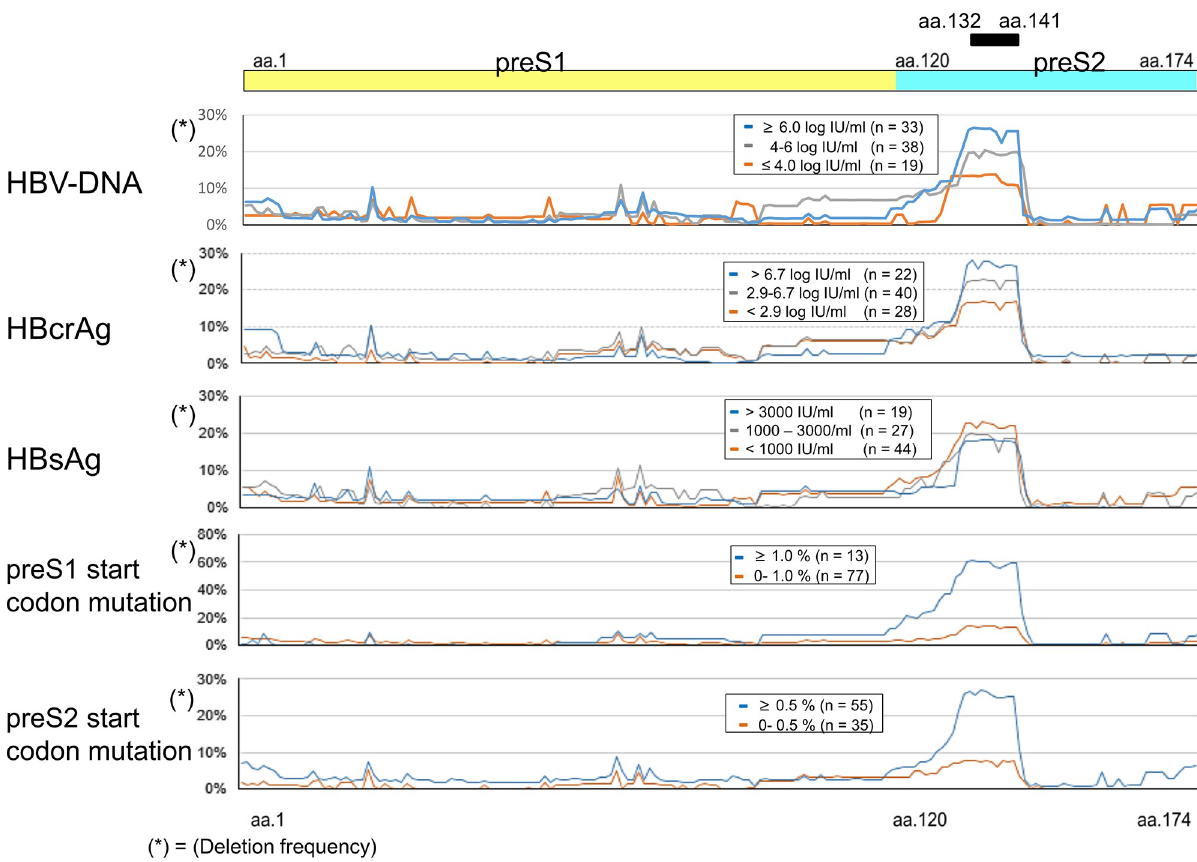
Fig 3. PreS deletion frequency and its association with viral markers. The preS deletion frequency and its association with viral markers (HBV DNA, HBcrAg, HBsAg, preS1 start codon mutation, and preS2 start codon mutation). A, The patients were stratified into three groups according to their HBV DNA titers( � 6.0 log IU/ml, n = 33, 4.0–6.0 log IU/ml, n = 38 and � 4.0 log IU/ml, n = 19). B. The patients were stratified into three groups according to their HBcrAg titers ( > 6.7 log IU/ml, n = 22, 2.9–6.7 log IU/ml, n = 40 and < 2.9 log IU/ml, n = 28). C. The patients were stratified into three groups according to their HBsAg titers ( > 3000 IU/m,; n = 19, 1000–3000 IU/ml, n = 27 and < 1000 IU/ml, n = 44). D. The patients were stratified into two groups according to the frequency of preS1 start codon mutations ( � 1.0%, n = 13 and 0.0–1.0%, n = 77). E. The patients were stratified into two groups according to the frequency of preS2 start codon mutations ( � 0.5%, n = 55 and 0.0–0.5%, n = 35).